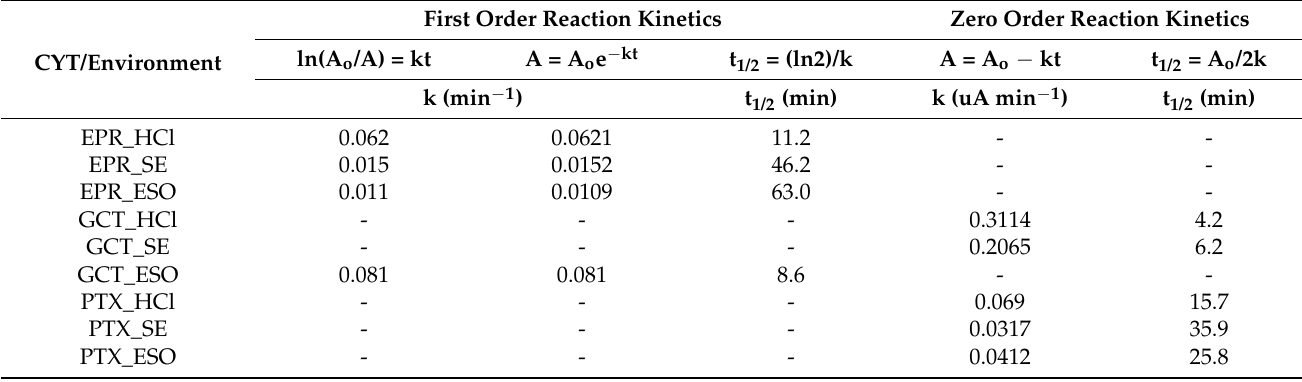
Table 3. Kinetic parameters computed for the electrodecomposition reaction of EPR, GCT and PTX in studied environments.